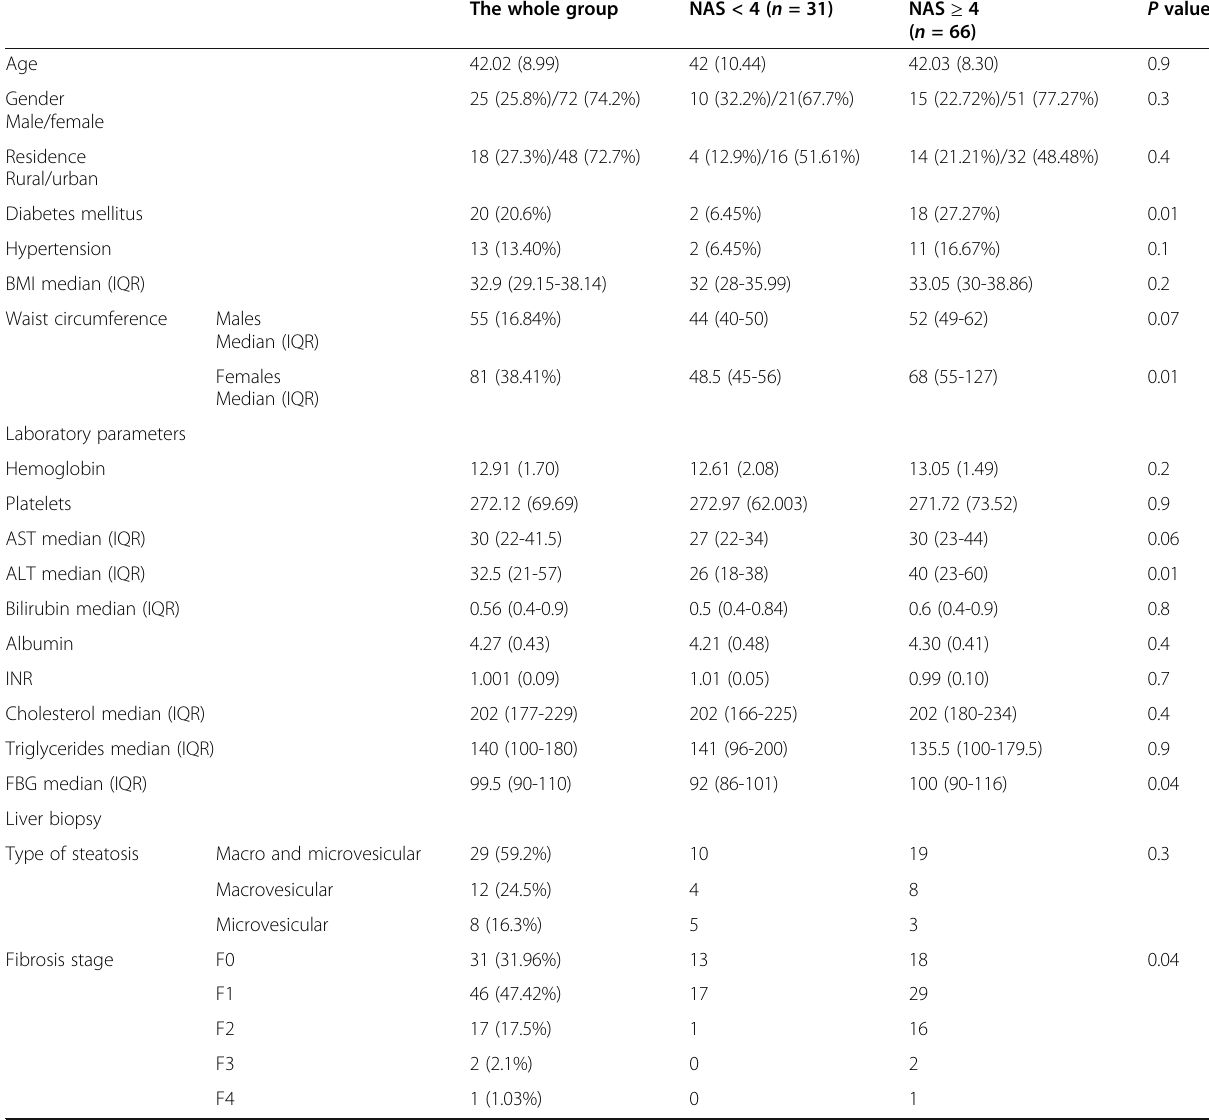
Table 1 Baseline characteristics of the study population